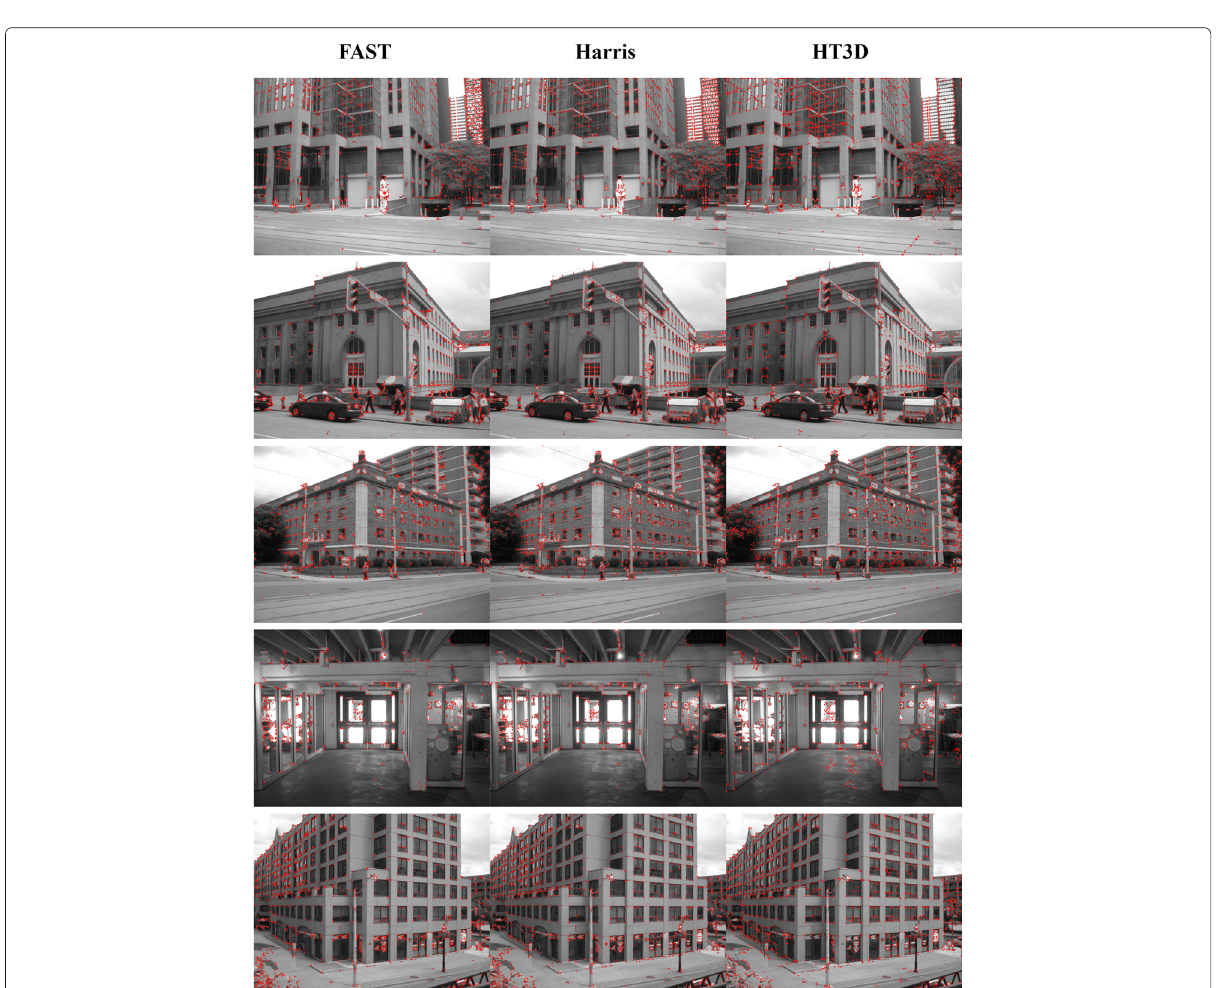
Fig. 14 Detected corners and endpoints for the second set of